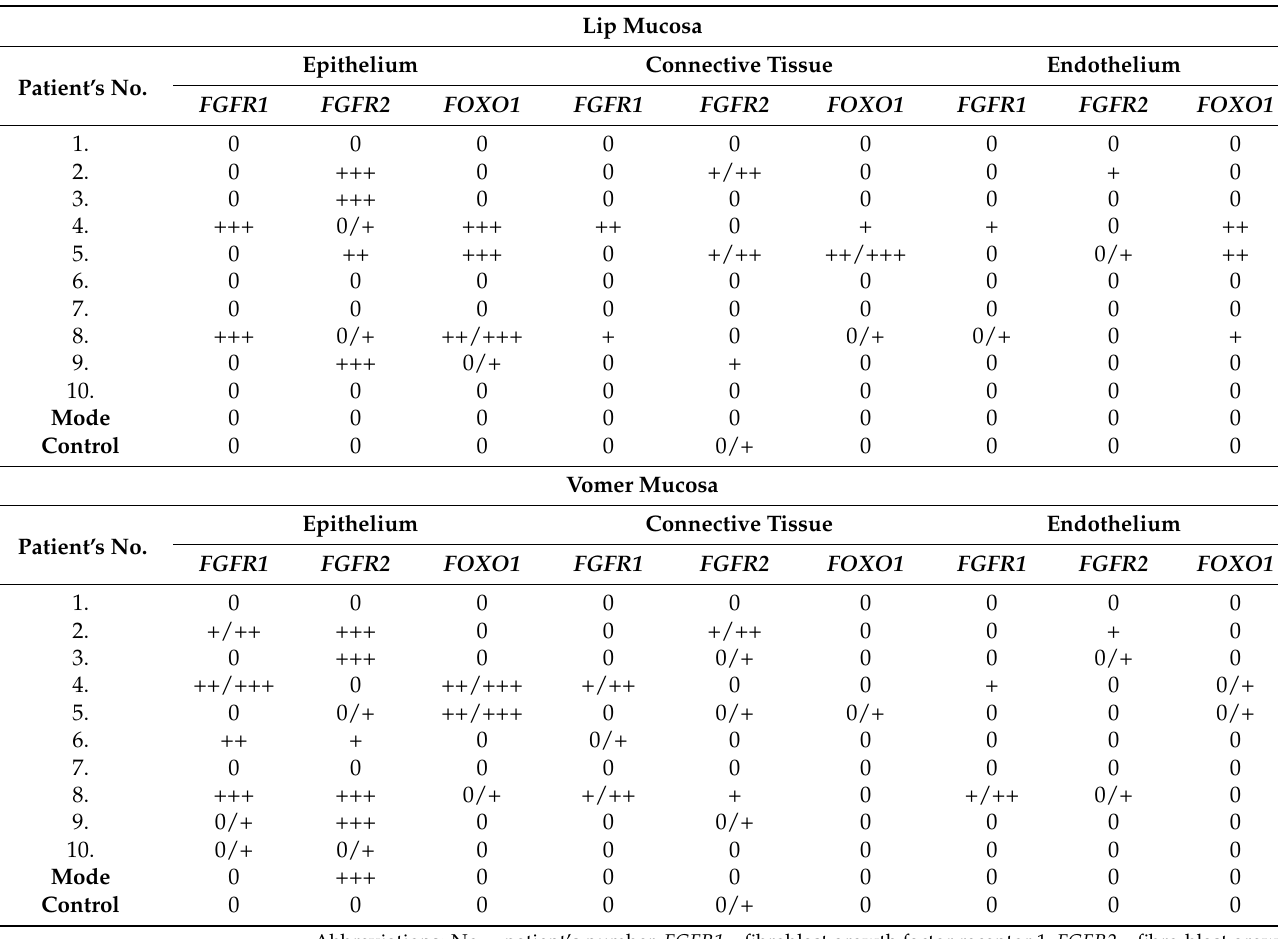
Table 2. The relative number of FGFR1 , FGFR2 and FOXO1 gene signals in the cleft-affected lip and palatine tissue samples as well as in the control